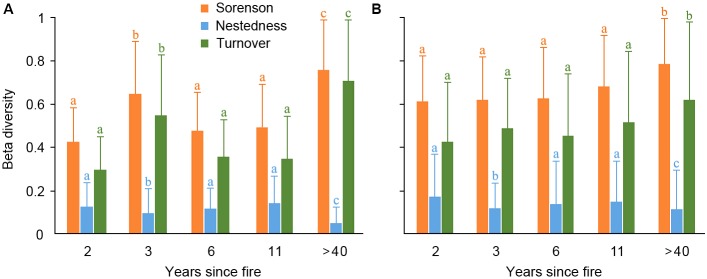
Total Beta diversity (Sorenson index, yellow) and its nestedness (blue) and turnover (green) components in the woody layer (A) and herbaceous layer (B) of post-fire plant communities of different year-since-fire (YSF). The error bar indicates the standard deviation. The letters on top of the error bars indicated a Tukey-Kramer test for multiple comparisons among post-fire communities of different YSFs, which was applied specifically for each beta diversity index (indicated by the same color).